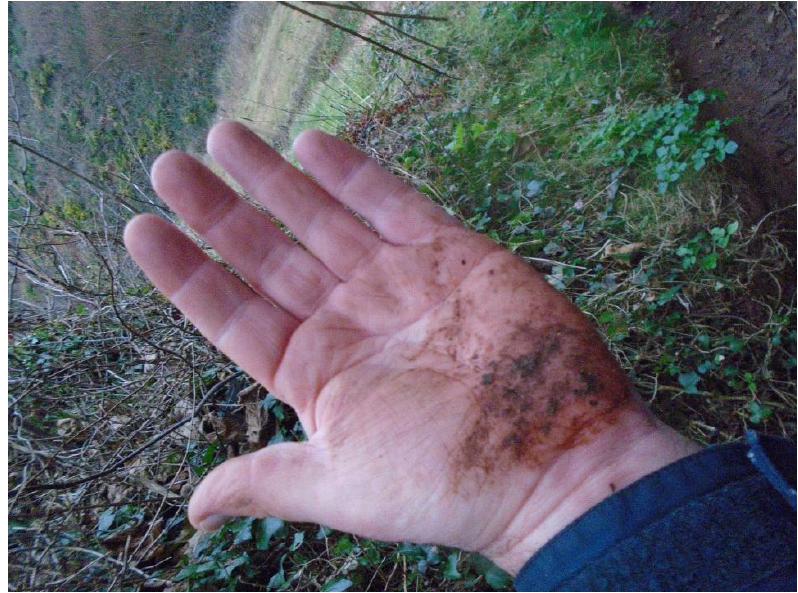
Figure 23. Mud from Langstone Point.